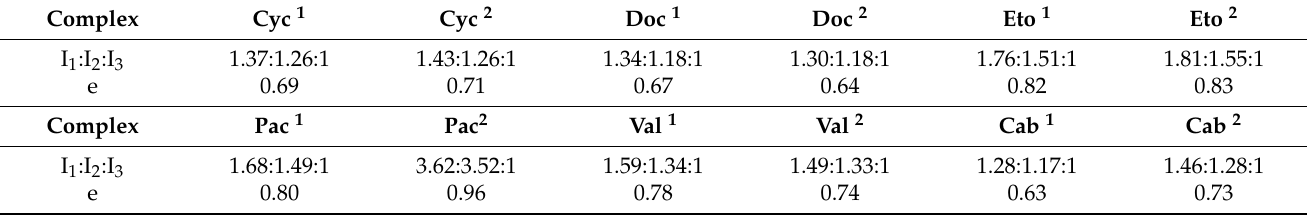
Table 3. The PAI ratio and eccentricity of the simulated